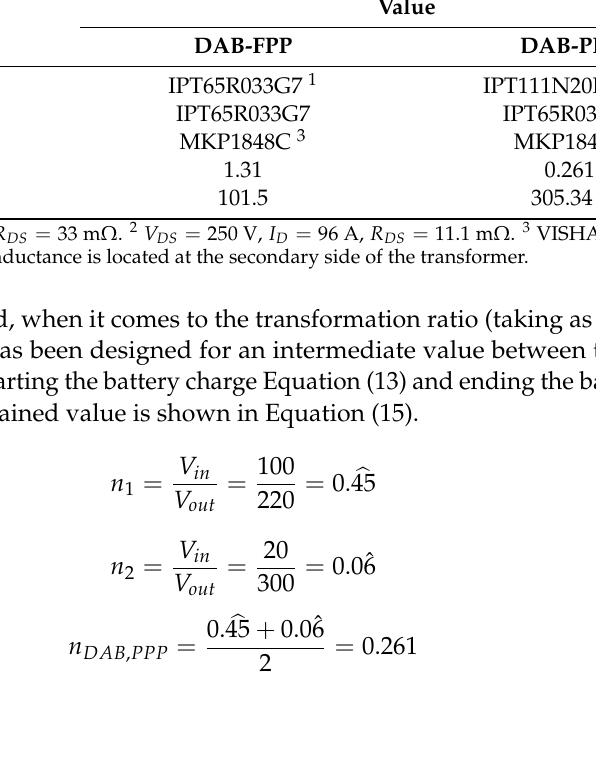
Table 4. Active and passive components of the DAB-FPP and DAB-PPP.